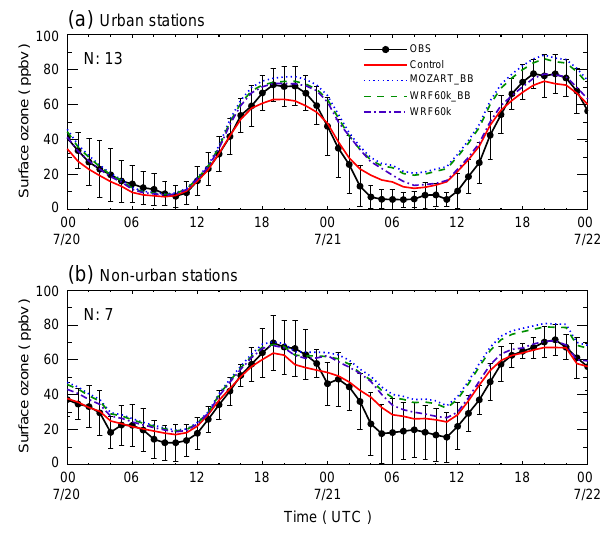
Fig. 18. Diurnal variations of observed and simulated O 3 mixing ra- tios averaged for (a) 13 urban stations and (b) 7 non-urban stations near New York City (75.0 ◦ W–73.0 ◦ W, 40.4 ◦ N–42.0 ◦ N). Vertical bars indicate spatial standard deviations of the observation. The twenty surface monitoring stations are classified into “urban” and “non-urban” classes following the land-use type assigned for the location of each station in the